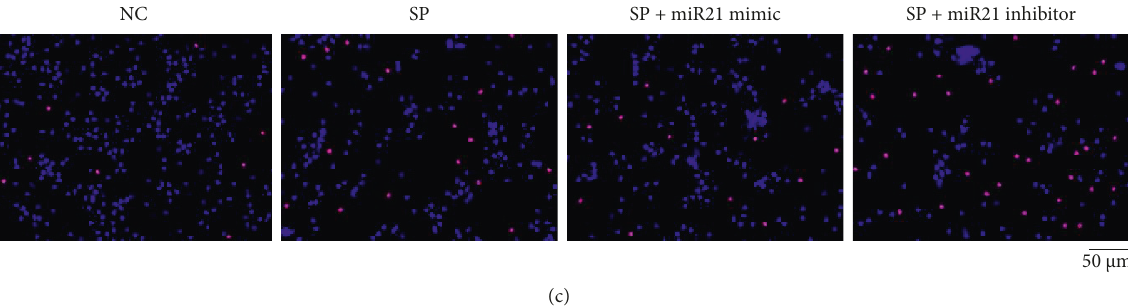
Figure 6: The percentages of apoptotic lymphocytes in peripheral blood were changed after transfection of miR-21 activator or inhibitor into lymphocytes of septic rats. (a) The percentages of apoptotic lymphocytes in eight-paired NC rat group, SP rat group, SP rat +miR21 mimic group, and SP rat +miR21 inhibitor group were determined by flow cytometry [ t value (NC versus SP) � 23.026, p < 0.01; t value (miR-21 mimic versus SP) � 17.872, p < 0.01; t value (miR-21 inhibitor versus SP � 23.921), p < 0.05]. (b) In in vivo experiments, apoptotic lymphocytes were detected by immunofluorescence microscope in in eight-paired NC rat group, SP rat group, SP rat +miR21 mimic group, and SP rat +miR21 inhibitor group. (c) In in vitro culture, apoptotic lymphocytes were detected by immunofluorescence microscope in in eight-paired NC rat group, SP rat group, SP rat+miR21 mimic group, and SP rat +miR21 inhibitor group. NC group: normal control group; SP group: sepsis group. SP rat+miR21 mimic group: sepsis group with miR-21 activator transfected into lymphocytes; SP rat+ miR21 inhibitor group: sepsis group with miR-21 inhibitor transfected into lymphocytes. ∗∗ p <